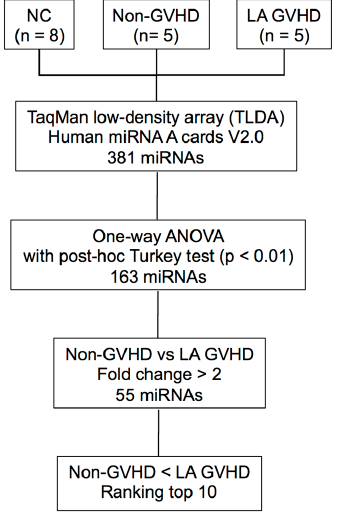
Figure 1. Flow diagram for the identification of late-onset acute GVHD-specific miRNAs. The exosomes fractions were isolated from 18 plasma samples of HSCT patients and healthy volunteers, and the expression profile of 381 exosomal miRNAs were analyzed. To validate candidate miRNAs, we performed TLDA and further narrowed down the miRNAs to those significantly differentially expressed by at least two-fold.